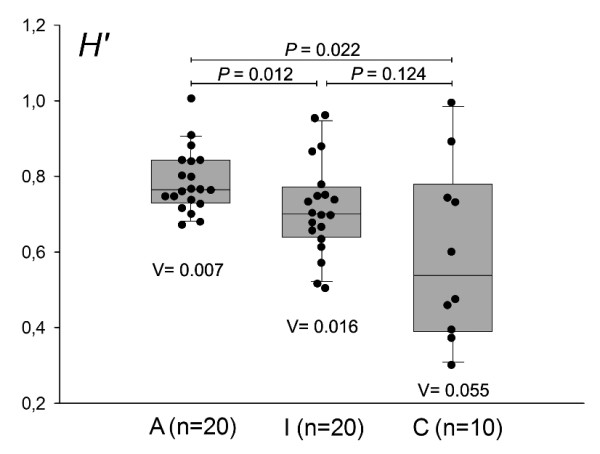
Duodenal microbial community biodiversity. Measure of estimated diversity within each biopsy sample obtained from TTGE profiles of CD patients studied during both active (A) and inactive (I) celiac disease, and controls (C). For each group, the diversity index (H'), according to Shannon-Weaver and the intra-group variance (V), are shown. The mathematical equation to calculate diversity index for each TTGE profile was with Pi = ni/Ntot, that takes in account the numbers of bands (s), their relative intensity (ni) and sum (Ntot). P values for each inter-group comparison are showed.